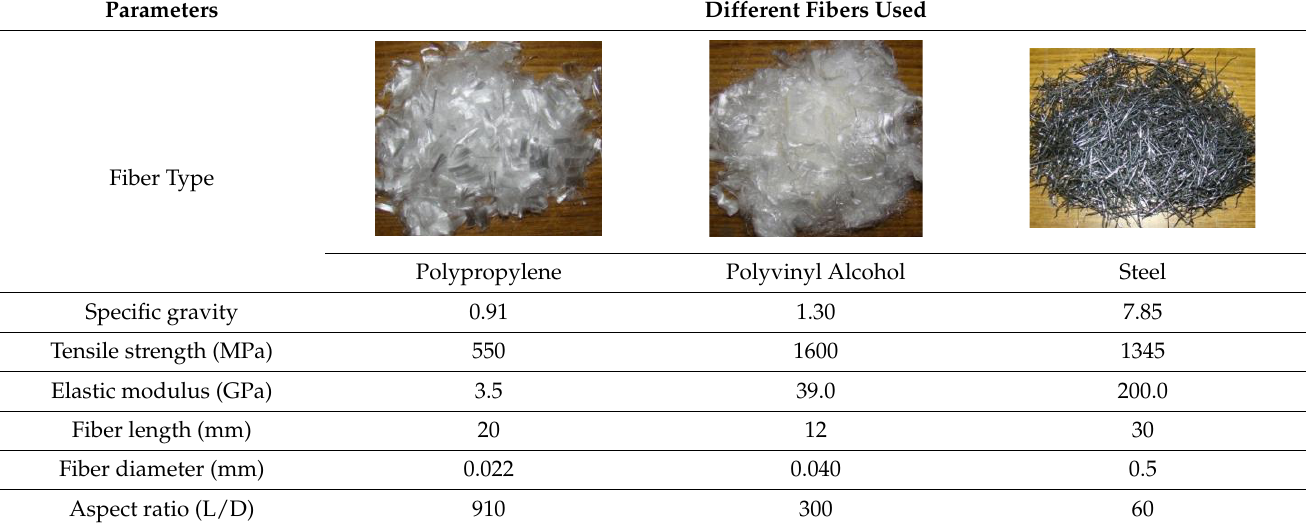
Table 1. Properties of fibers used.